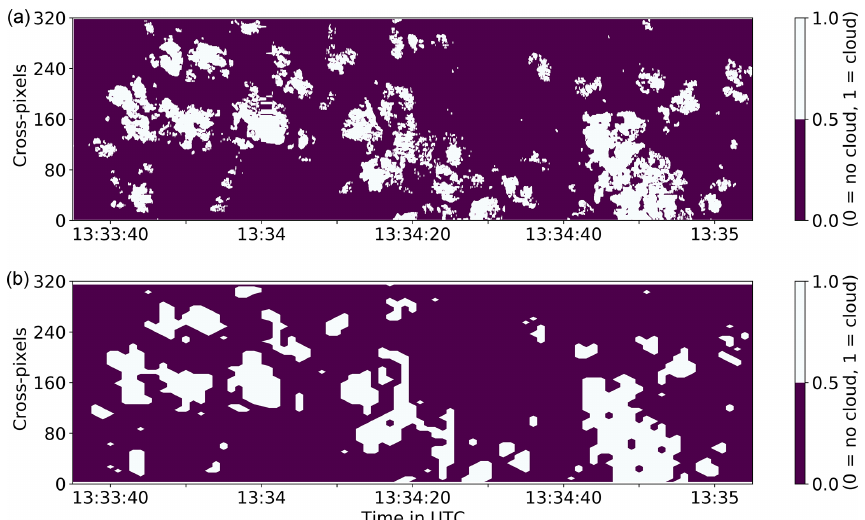
Figure 4. Imager cloud mask (specMACS) of shallow cumuli from RF07 in a standard (a) and coarse-regridded resolution (b) . Each imager across-track pixel has a FOV of 0.22 ◦